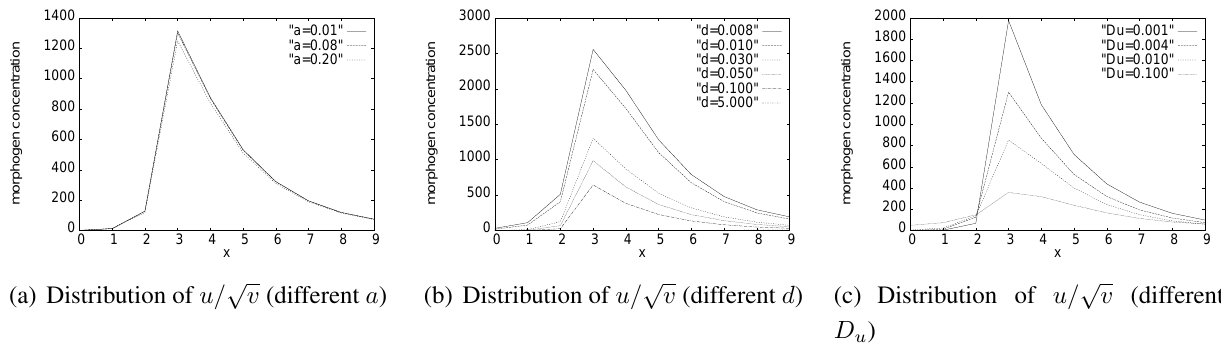
Figure 13 . Simulation results of one moving target for different parameter